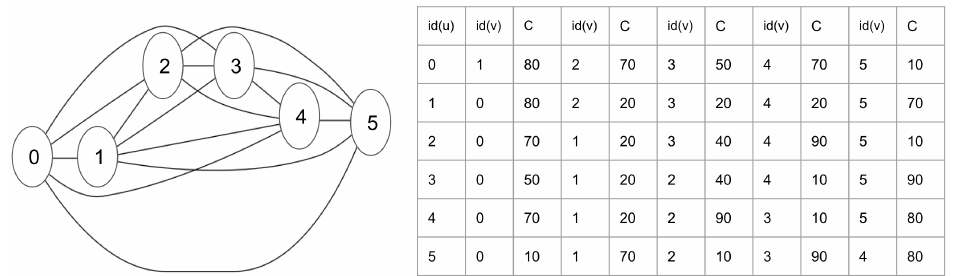
Figure 3. The left graph is a fully connected six-vertex graph. The right table shows the adjacency matrix to represent the cost of traveling between two vertices.